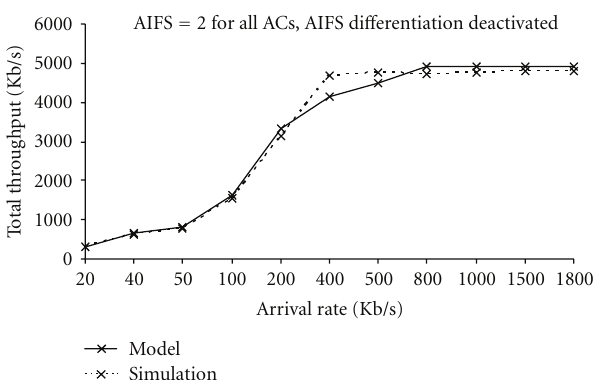
Figure 28: Total achievable throughput —AIFS deactivated.